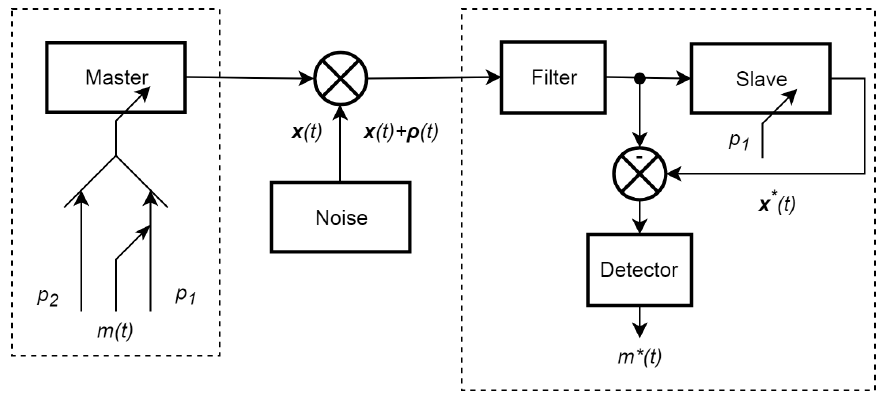
Figure 7. Chaotic communication system with filter.